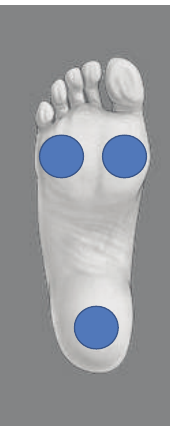
Figure 2: NeuroCom EquiTest system. Participants stood on cus- tomized soles with embedded vibrating units during all